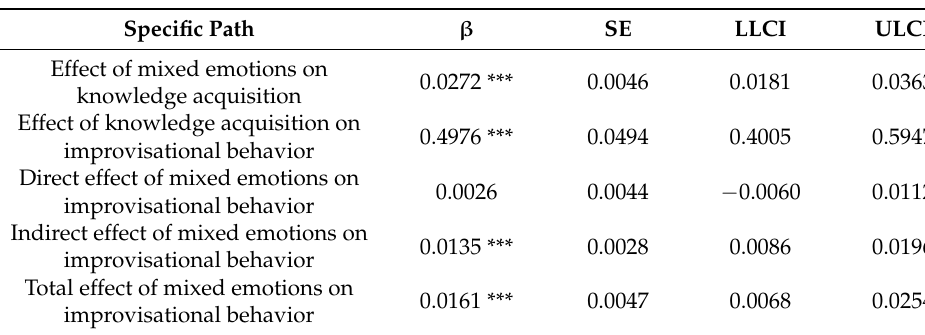
Table 2. Analysis of hypothetical effects.